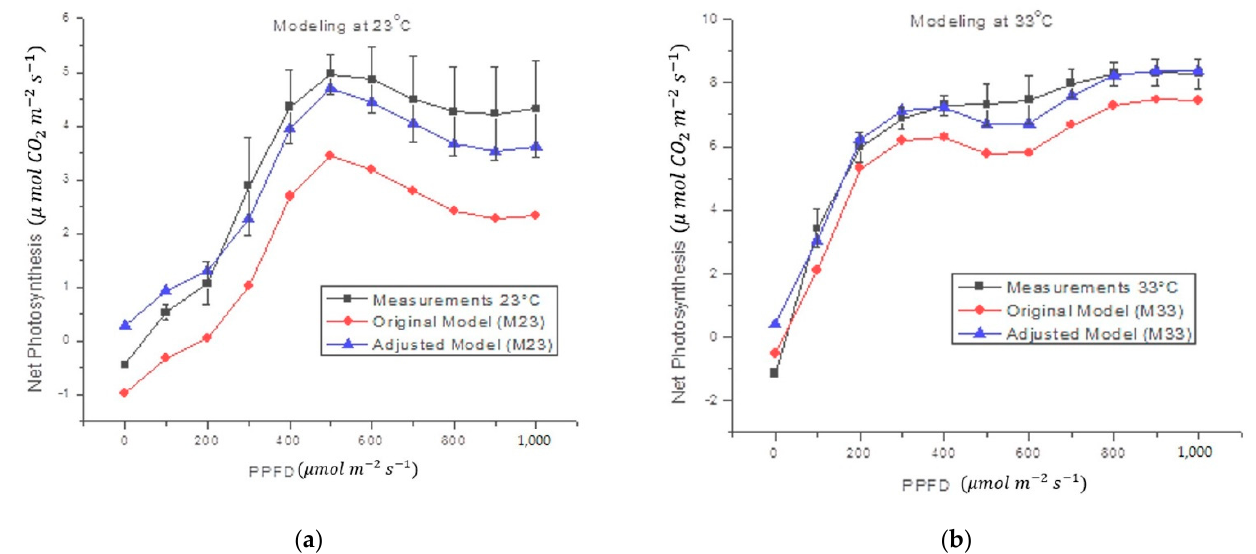
Figure 6. Comparison between the average of NP estimate in Capsicum annuum L. and the proposed mathematical model at different air temperatures. The original model refers to Equation (2) and the fitted models include O a , Equation (4). Table 5. The statistical values of the net photosynthesis estimate compared with the original model M23 (OM23), the fitted model M23 (AM23), the original model M33 (OM33), and the fitted model (AM33). All statistics were calculated for Capsicum annuum L. ( C. annuum L.) and Capsicum chinense Jacq. ( C. chinense Jacq.). Measurements in Capsicum annuum L. were carried out at 23 °C for M23 and at 33 °C for M33. To study the behavior of the model, measurements were made on Capsicum chinense Jacq. they were prepared at 29.8 °C, and compared with M23 and M33.